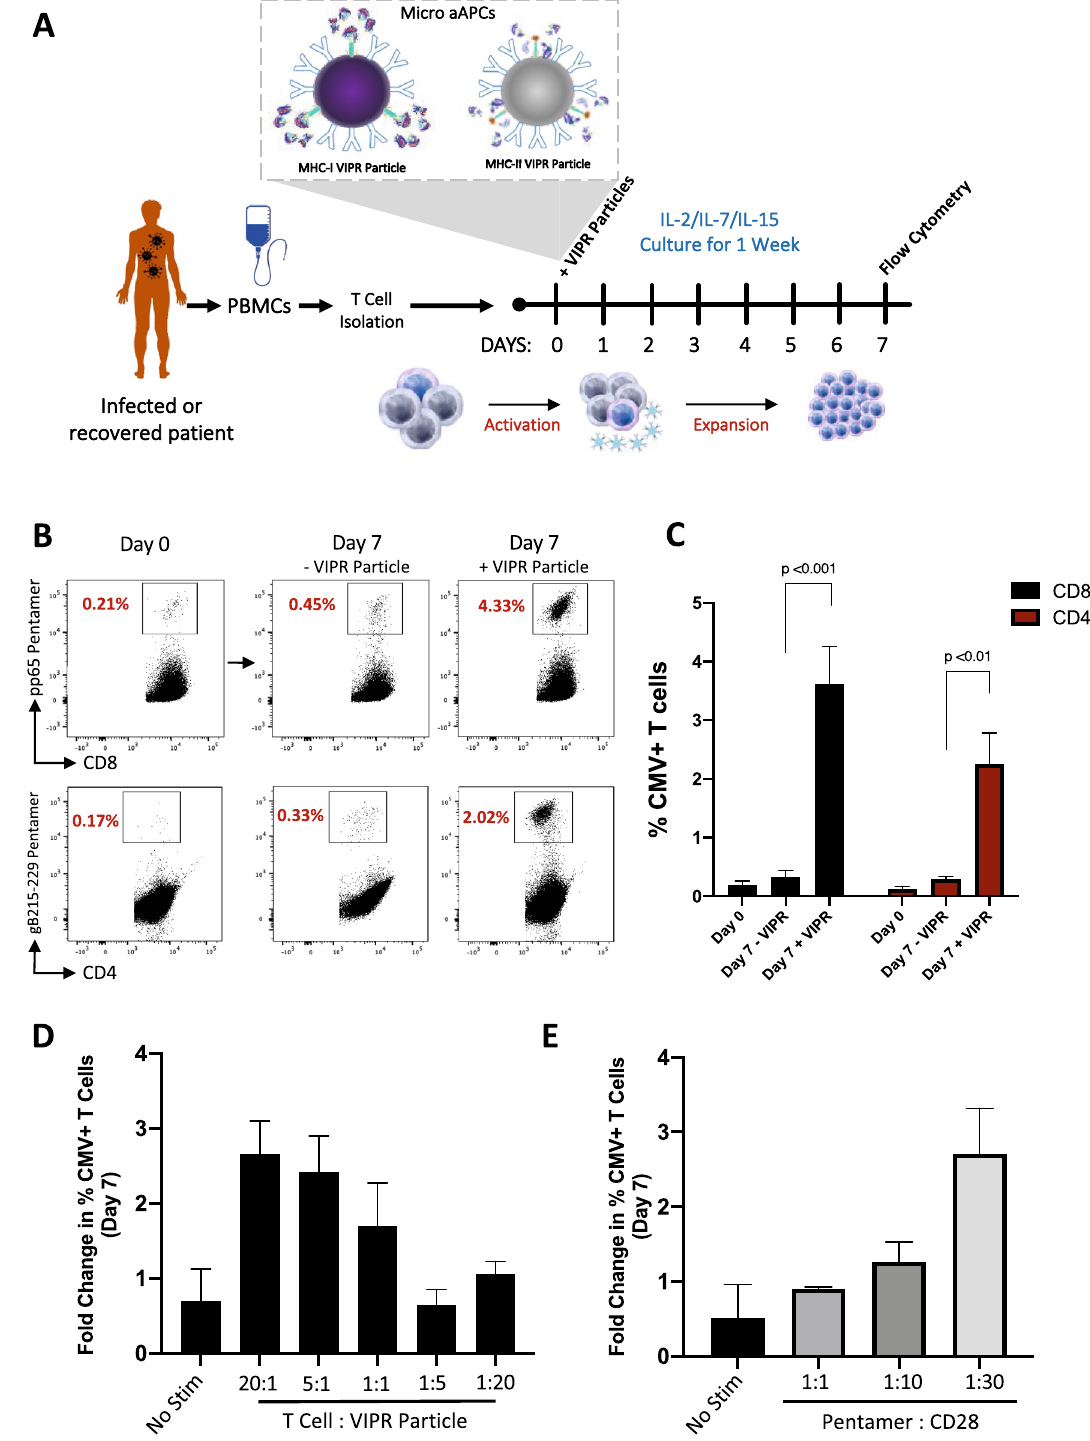
Figure 1. Detection and enrichment of antigen-specific Virus Induced Lymphocytes (VIL) in CMV infected individuals. ( A ) Strategy for the isolation, stimulation and enrichment of CMV antigen-specific T cells from donor PBMCs. ( B ) Representative flow-cytometric analysis showing proportions of antigen-specific CD8 + and CD4 + T cells identified by Pentamer staining, 7-days after enrichment and expansion with antigen-specific VIPR Particles. ( C ) Summary of CD8 + and CD4 + data obtained in b, ( n = 3). ( D ) Histogram plot showing this VIL enrichment at day 7 is VIPR particle dose-dependent ( n = 3). ( E ) Histogram showing impact on VIL enrichment at day 7 of MHC-I pentamer and anti-CD28 ratio conjugated to VIPR particles ( n =